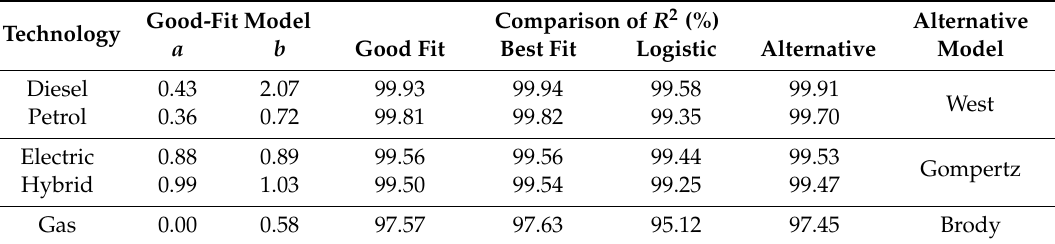
Table 5. Models with good fits to all data for certain